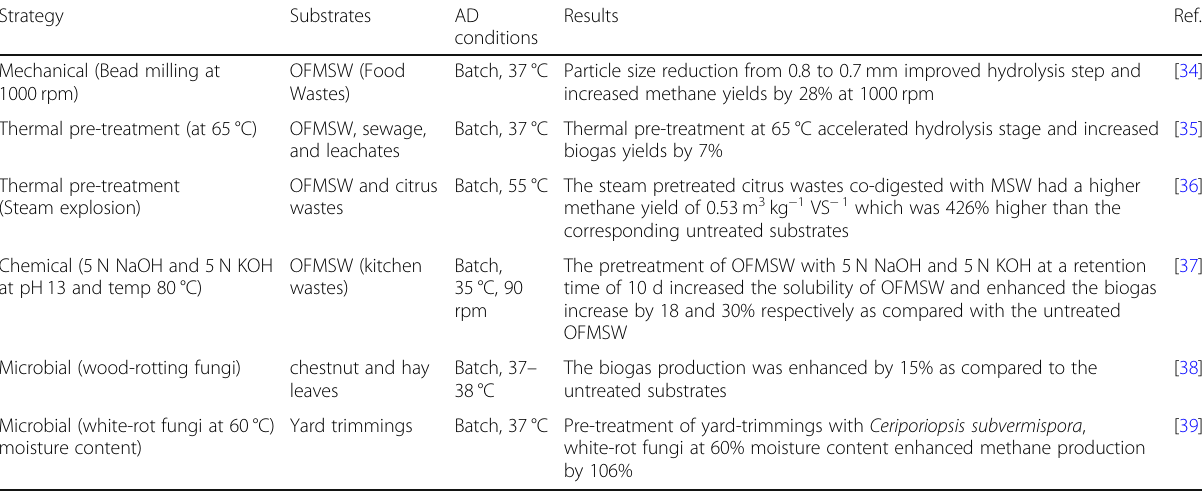
In the second stage of the AD process which is acido- genesis, a large group of facultative and obligate anaer- obic bacteria converts the products of hydrolysis into other forms to be used in subsequent phases. For in- stance, sugars, amino acids, and fatty acids are converted into organic acids or volatile fatty acids (VFAs), alcohols, and some inorganic compounds such as CO , H , H S 2 2 2 and NH [33]. Equations (2), (3) and (4) represent the 3 reactions in this stage. Acetogenesis is the third stage of the anaerobic meta- bolic stage where acetogenic bacteria convert the prod- ucts of acidogenesis into acetate, hydrogen and carbon dioxide [29, 40].The overall reactions in this stage are represented by Eqs. (5), (6) and (7). Results Ref. conditions